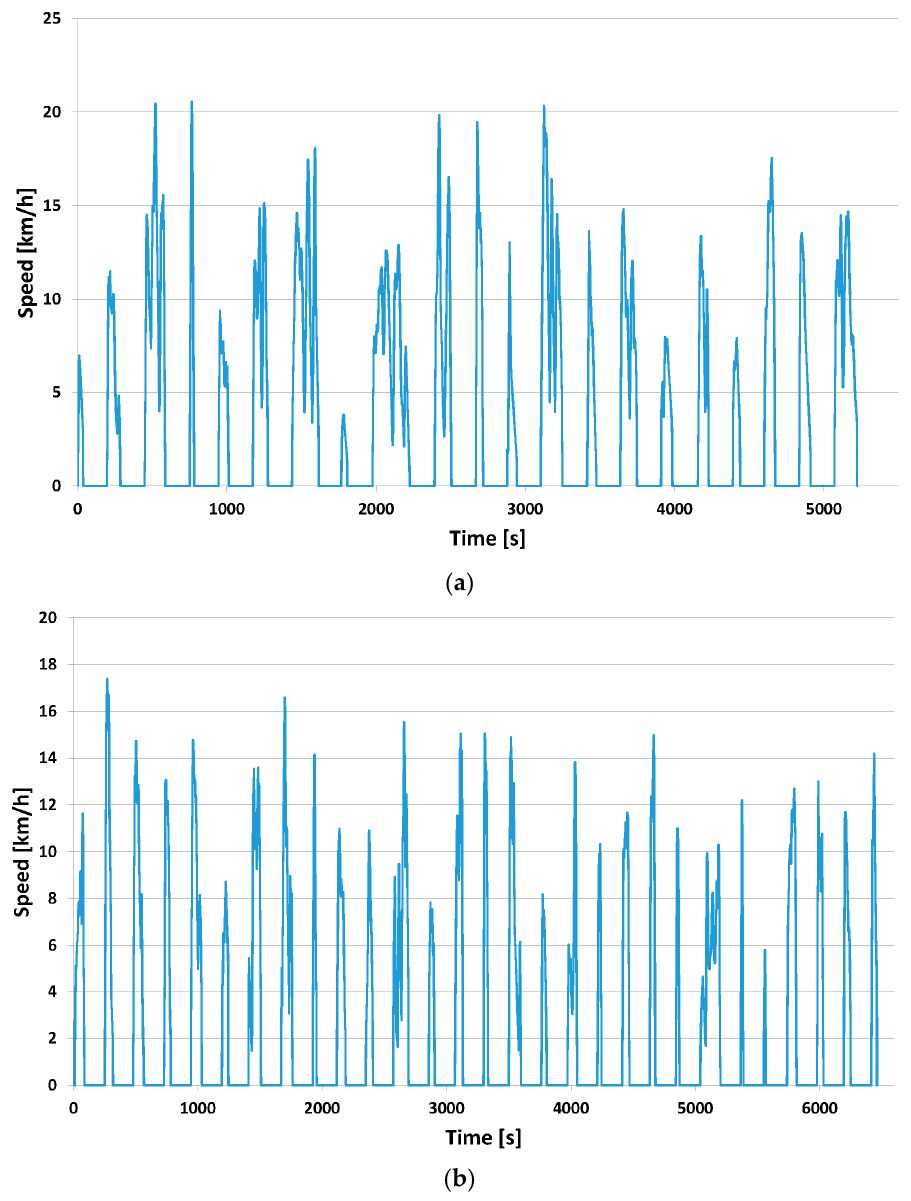
Figure 10. ( a ) Modified speed profile of route 1. ( b ) Modified speed profile of route 2.